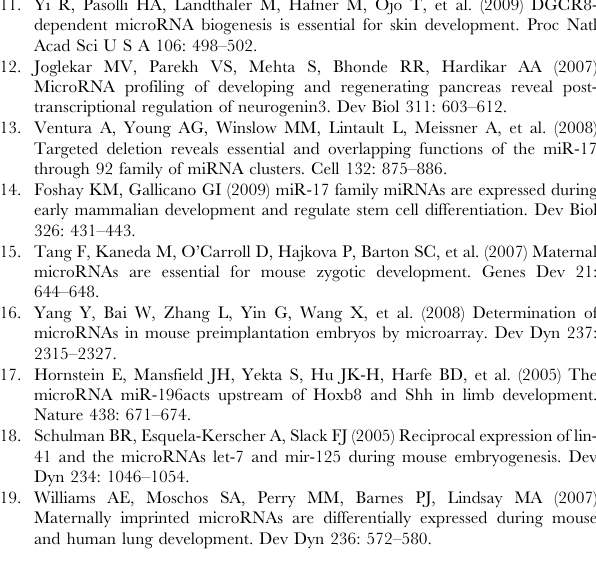
Figure S2 Clustering of replicate samples for heatmap shown in Fig. 2a. Found at: doi:10.1371/journal.pone.0006143.s002 (0.06 MB Figure S3 Clustering of replicate samples for heatmap shown in Fig. 2c Found at: doi:10.1371/journal.pone.0006143.s003 (0.07 MB Figure S4 Clustering of replicate samples for heatmap shown in Fig. 4a. Found at: doi:10.1371/journal.pone.0006143.s004 (0.06 MB Figure S5 Differentially expressed miRNAs for TS cells induced to differentiate by withdrawal of FGF4. Values plotted as ranked fold change. Table S1 Comparison of miRNA expression in BD-TS vs ES- TS cells by comparative marker selection. Data are sorted by SNR statistic score and only scores . 0.5 or ,2 0.5 are shown. Table S2 Comparative marker selection analysis on iRas-ES cells induced for 44 hrs vs. iRas-ES cells cultured without doxycycline. Data are sorted by SNR statistic score and only scores . 0.5 or ,2 0.5 are shown.